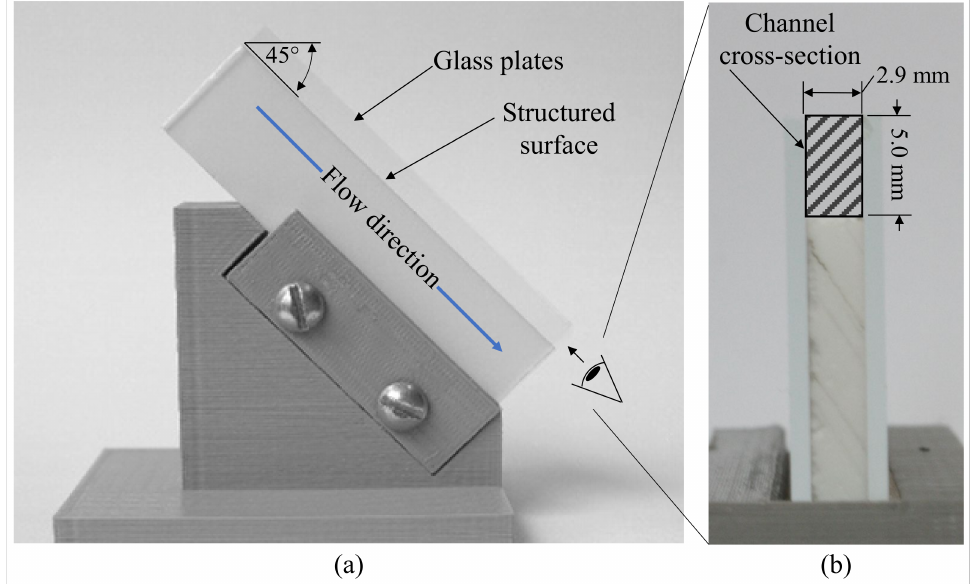
Figure 11. Experimental apparatus ( a ) showing sample inclination angle of 45 ◦ and ( b ) view from outlet showing channel cross-section delineated by two glass plates and the structured